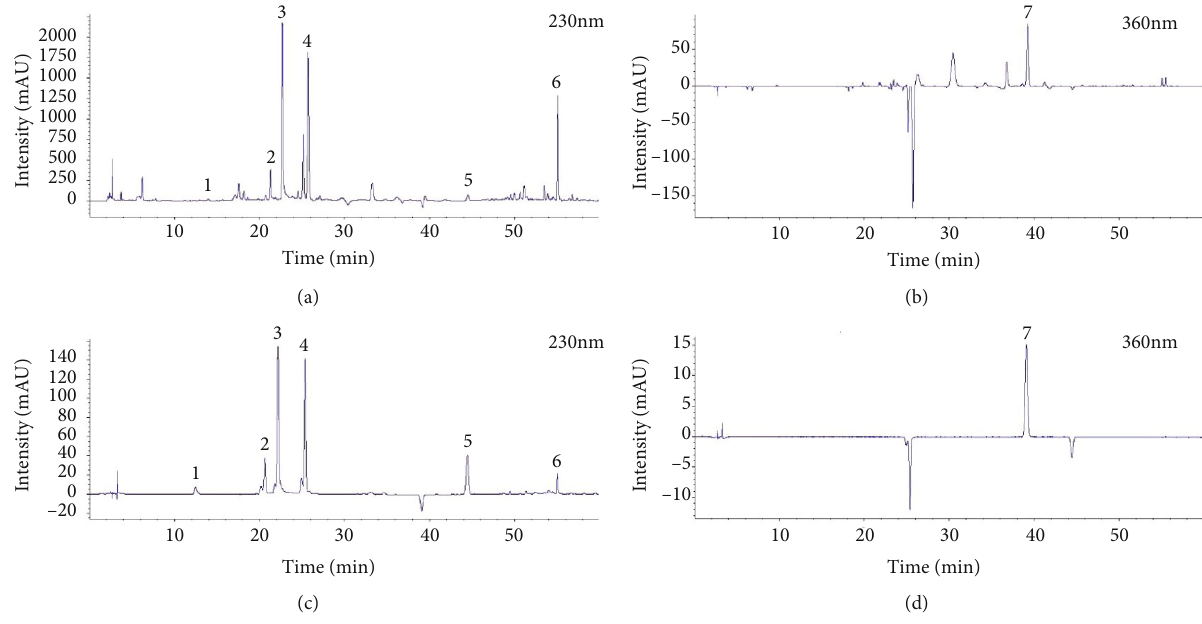
Figure 2: HPLC chromatograms of seven analytes in SGD and standard mixture. (a, b) HPLC chromatograms of seven analytes in SGD at 230nm (a) and 360 nm (b). (c, d) HPLC chromatograms of seven analytes in a standard mixture at 230 nm (c) and 360 nm (d). The meaning of numbers was as follows: (1) oxypaeoni fl orin, (2) albi fl orin, (3) paeoni fl orin, (4) liquiritin, (5) liquiritigenin, (6) glycyrrhizin, and (7) isoliquiritin.